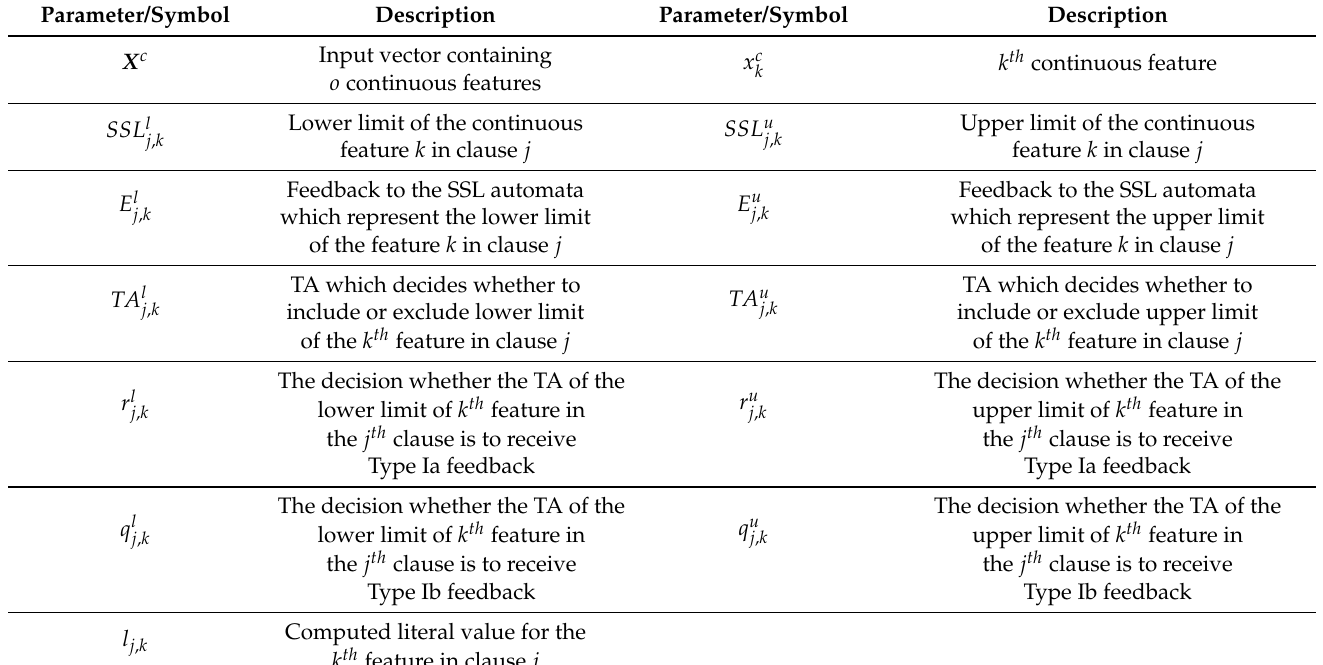
Table 3. Parameters and symbols used in Section